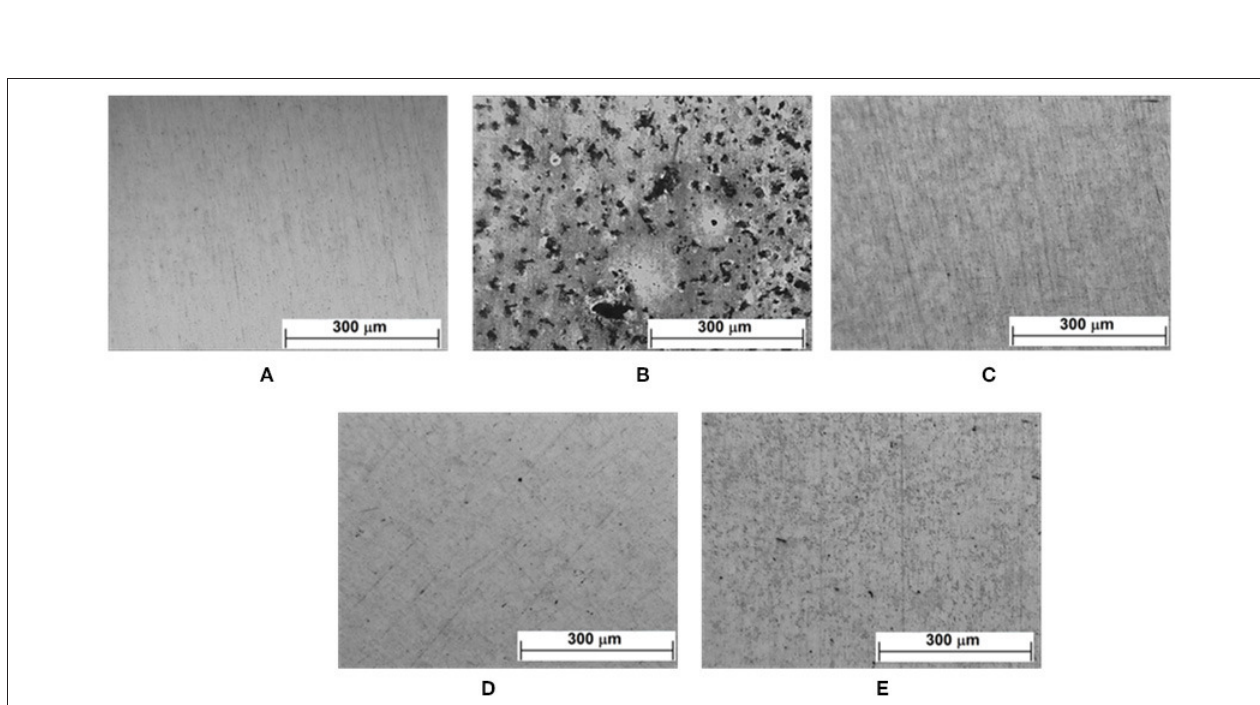
FIGURE 12 | Optical micrographs of the zinc surface after conditioning in a humid chamber for 7 days in the absence and presence of VCIs: (A) after polishing; (B) without inhibitor; with inhibitor after 7 days of immersion (C) CCHA; (D) CDCHA; (E) CETA.